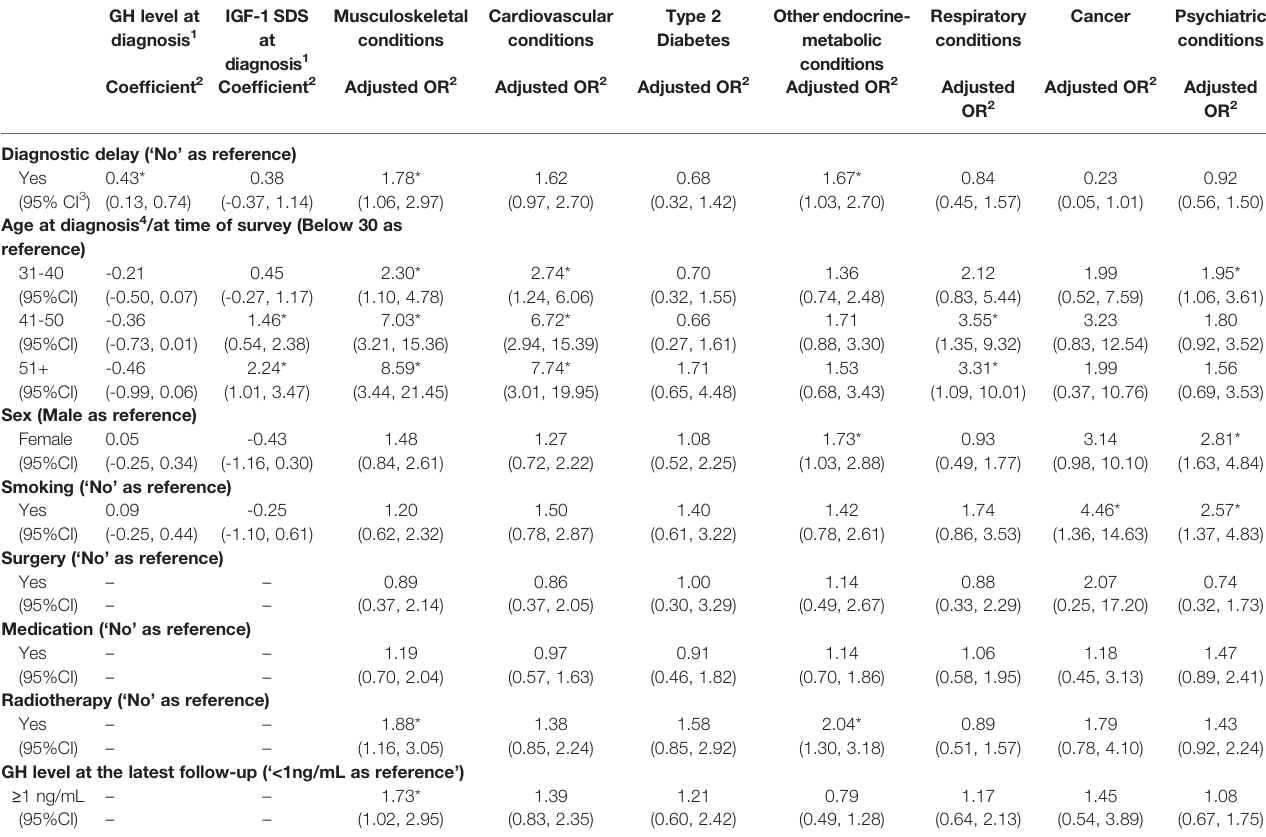
TABLE 5 | Association of diagnostic delay with GH and IGF-1 level and comorbidities. GH level at diagnosis